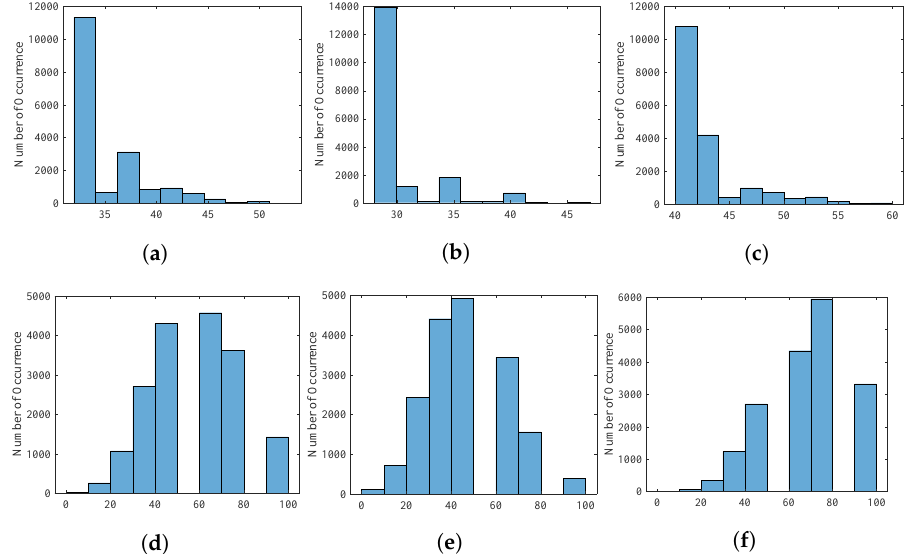
Figure 12. Validation data characteristics of the AdaDelta model (five layers) with Z-score: ( a ) unique- ness of nonce 1; ( b ) uniqueness of nonce 2; ( c ) uniqueness of port; ( d ) randomness of nonce 1; ( e ) randomness of nonce 2; ( f ) randomness of